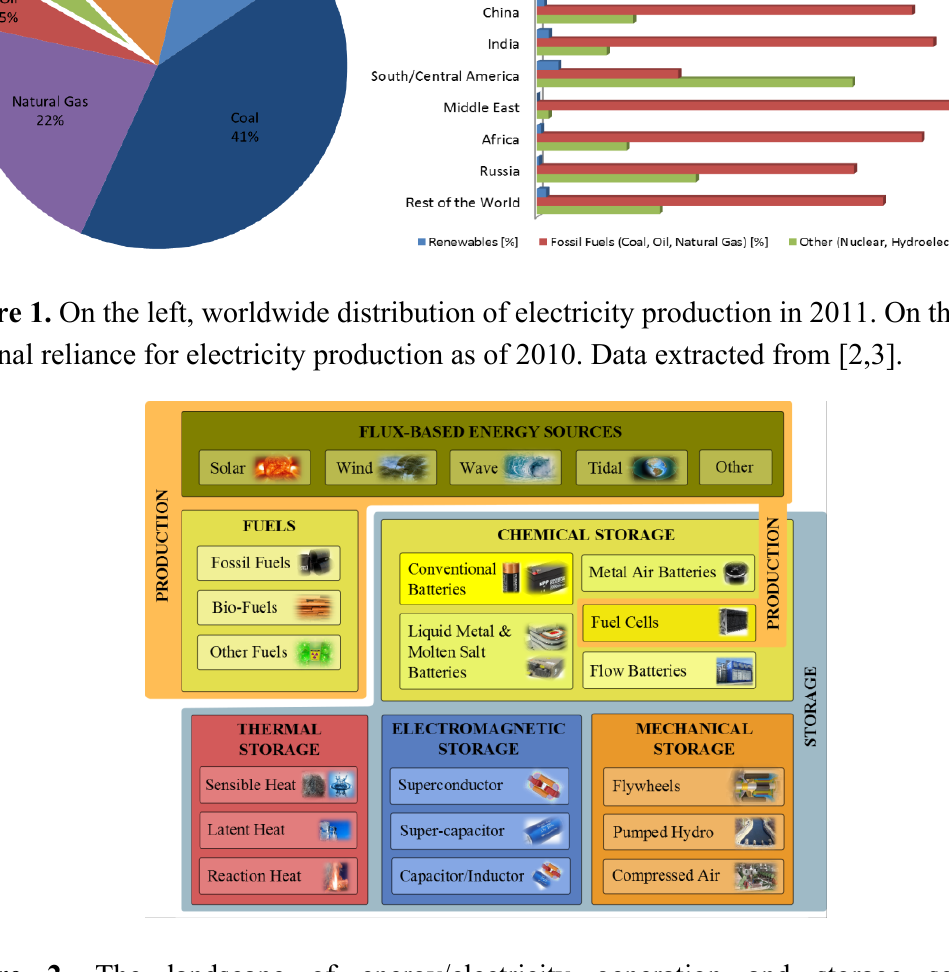
Figure 2. The landscape of energy/electricity generation and storage